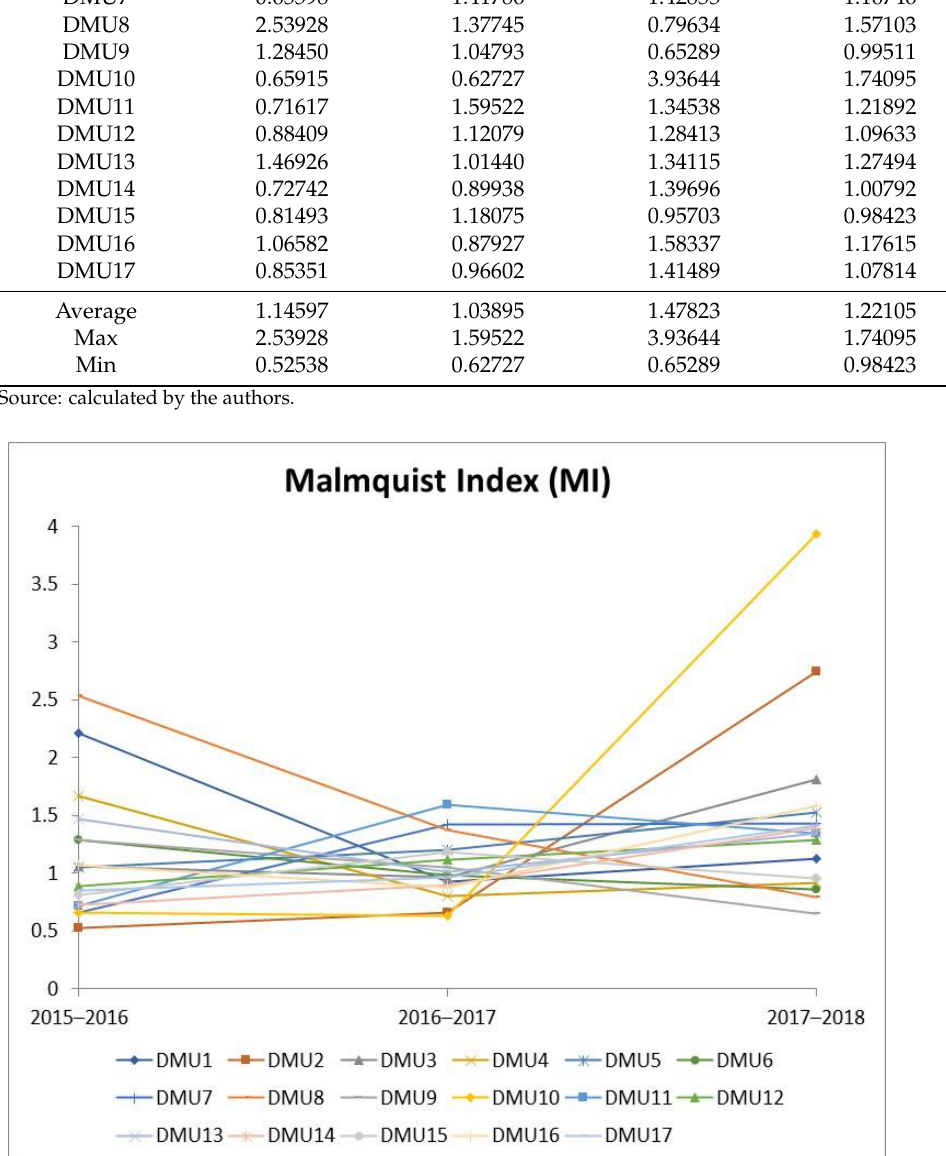
Figure 5. Total factor productivity change.